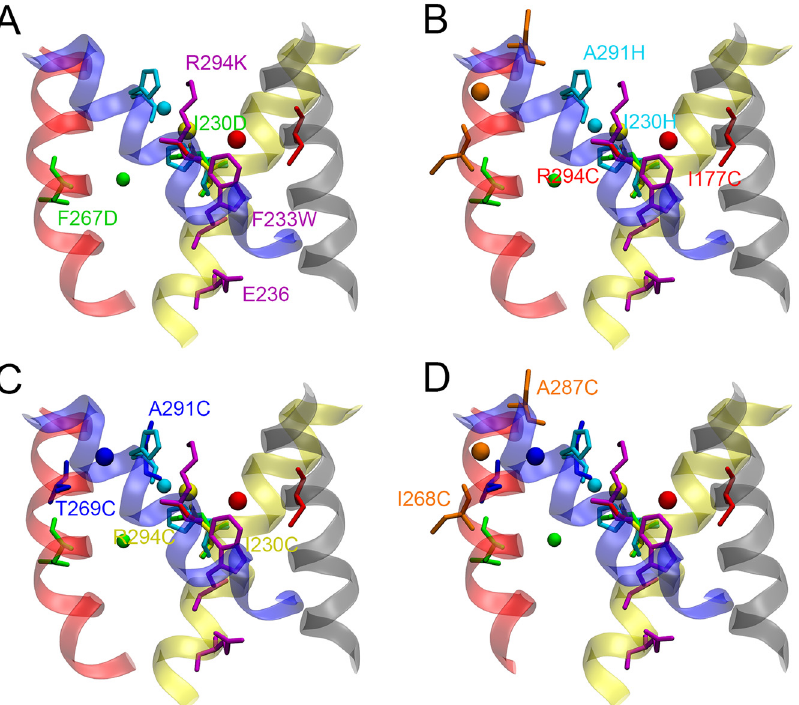
Fig 2. Starting configurations of the four models of the VSD with different molecular fragments. (A) model-1. (B) model-2. (C) model-3. (D) model-4. The four TM helices, S1 (gray), S2 (yellow), S3 (red) and S4 (blue), are represented in transparent ribbons. Molecular fragments, I177C – Cd 2+ – R294C, I230C – Cd 2+ – R294C, I230D – Mg 2+ – F267D, F233W/E236 – R294K, I230H – Zn 2+ – A291H, I268C – Cd 2+ – A287C, and T269C – Cd 2+ – A291C, are colored in red, yellow, green, magenta, cyan, orange, and blue, respectively, with amino acids being represented in sticks and ions in spheres.